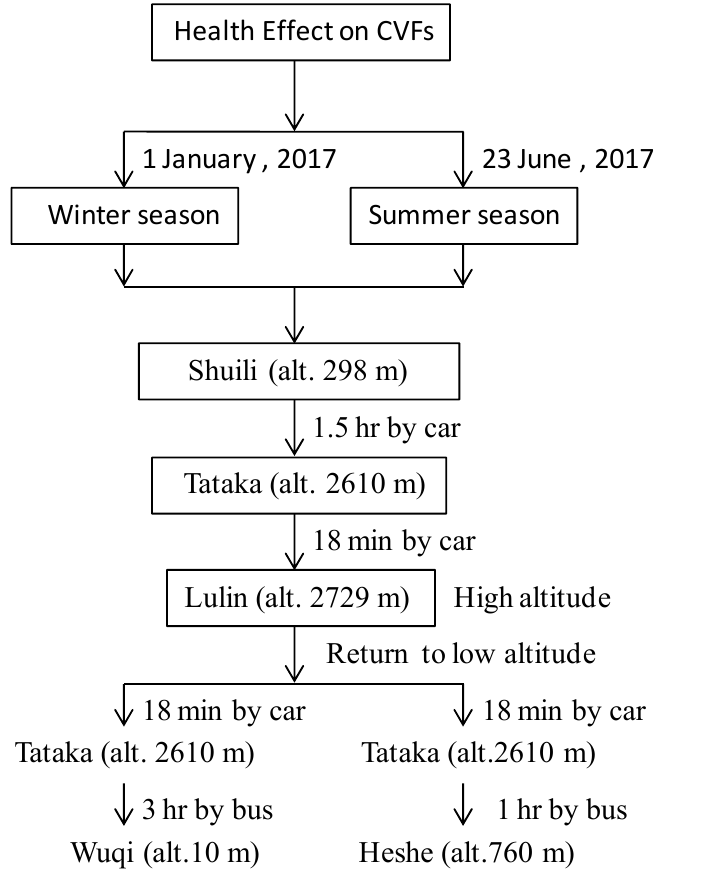
Figure 2. Flow chart illustrating the time points and altitudes of examination from low (starting) to high altitude, and rechecking of CVFs from high to low altitude.